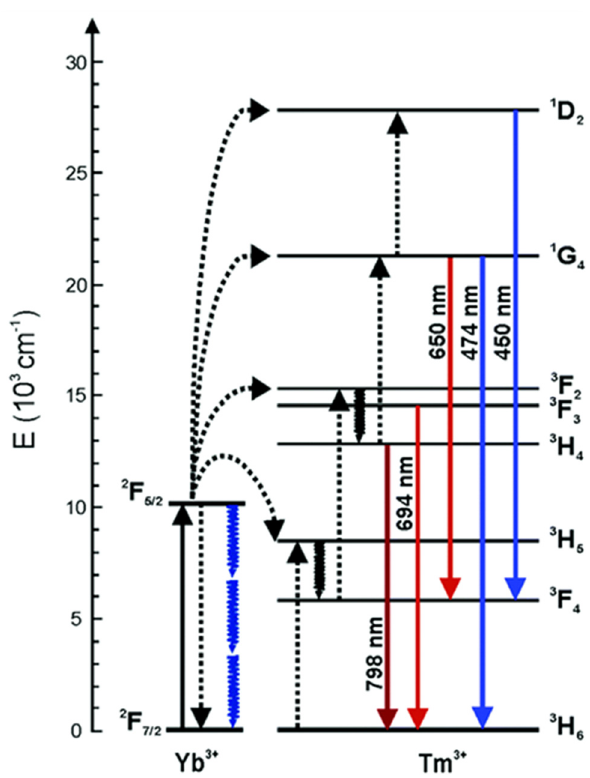
Figure 15: Energy - level diagram of Yb 3 + and Tm 3 + ions explaining the mechanism of up - conversion. Solid, dotted, and wavy arrows re - present photon absorption/emission, energy - transfer, and non - ra - diative relaxation processes, respectively [ 63 ]